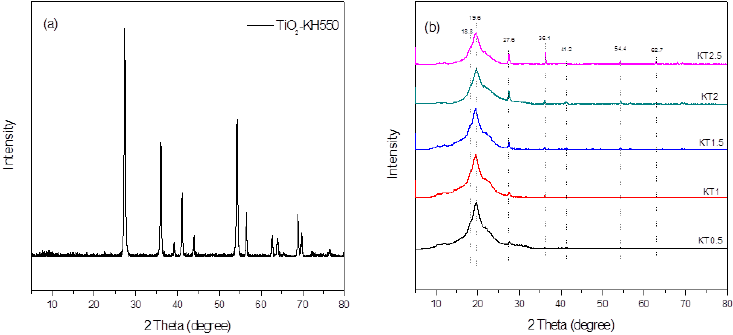
Figure 9. XRD of TiO 2 -KH550 ( a ) and the composite films ( b ).